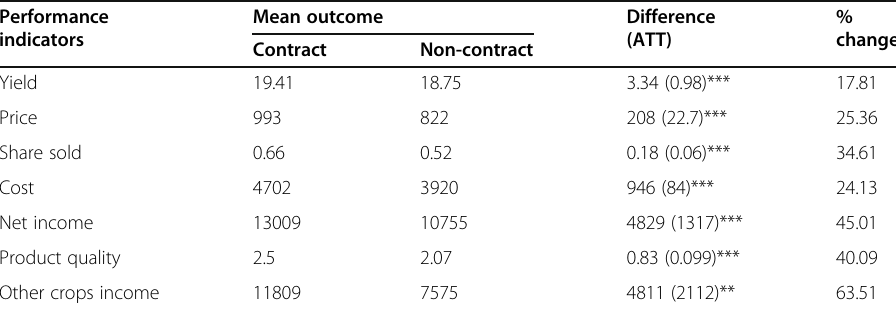
Table 3 Average treatment effects using IPWRA Performance